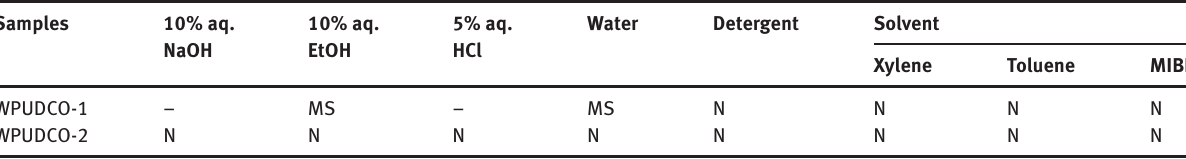
Table 5: Chemical resistance properties of polyurethane (PU)-prepolymer.